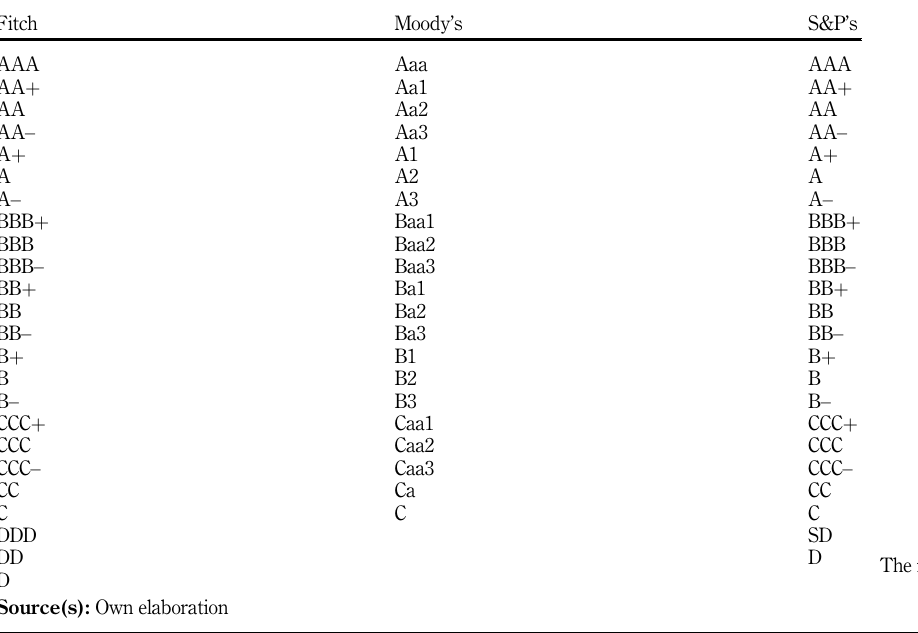
Table 3. The notations used